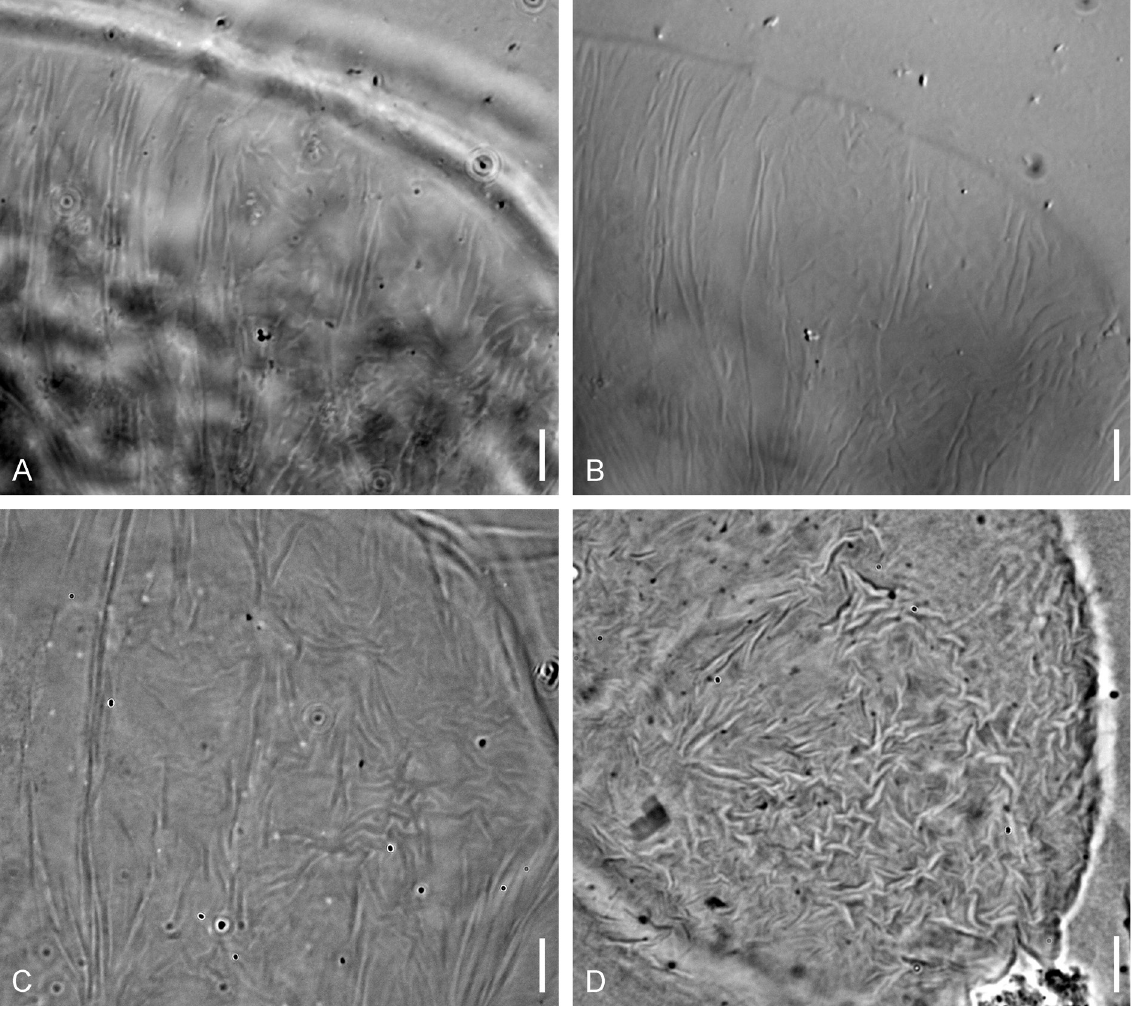
Fig. 2. Hypsibius pallidoides Pilato, Kiosya, Lisi, Inshina & Biserov, 2011, dorsal sculpture. A . Type series specimen (KNU Чер-9 II), PhC. B . Type series specimen (KNU Чер-9 II), DIC. C . Specimen from Austria (SPbu 251(82)), PhC. D . Specimen from Russia (SPbu 113(3)). Scale bars = 5